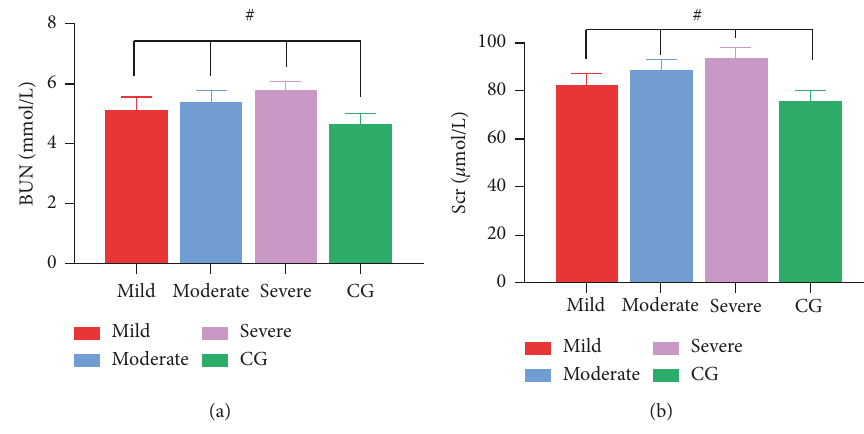
Figure 1: Comparison of renal function indicators among groups. Table 3: Comparison of liver function indicators among patients in each group ( x ± s ).